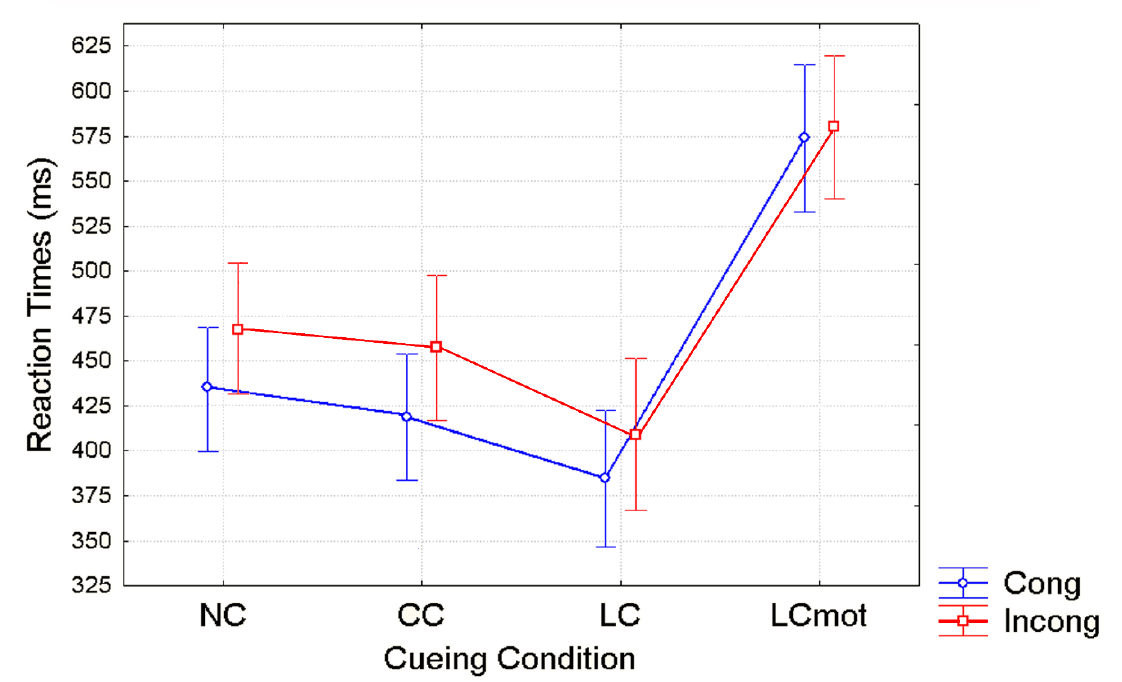
Figure 4. Mean RT and Standard Error (SE) values obtained as a function of the cueing condition and target congruency over the sample of participants. Note that RTs were measured starting from the target delivery time, that is 500 ms later than the cue omission or administration according to the cueing